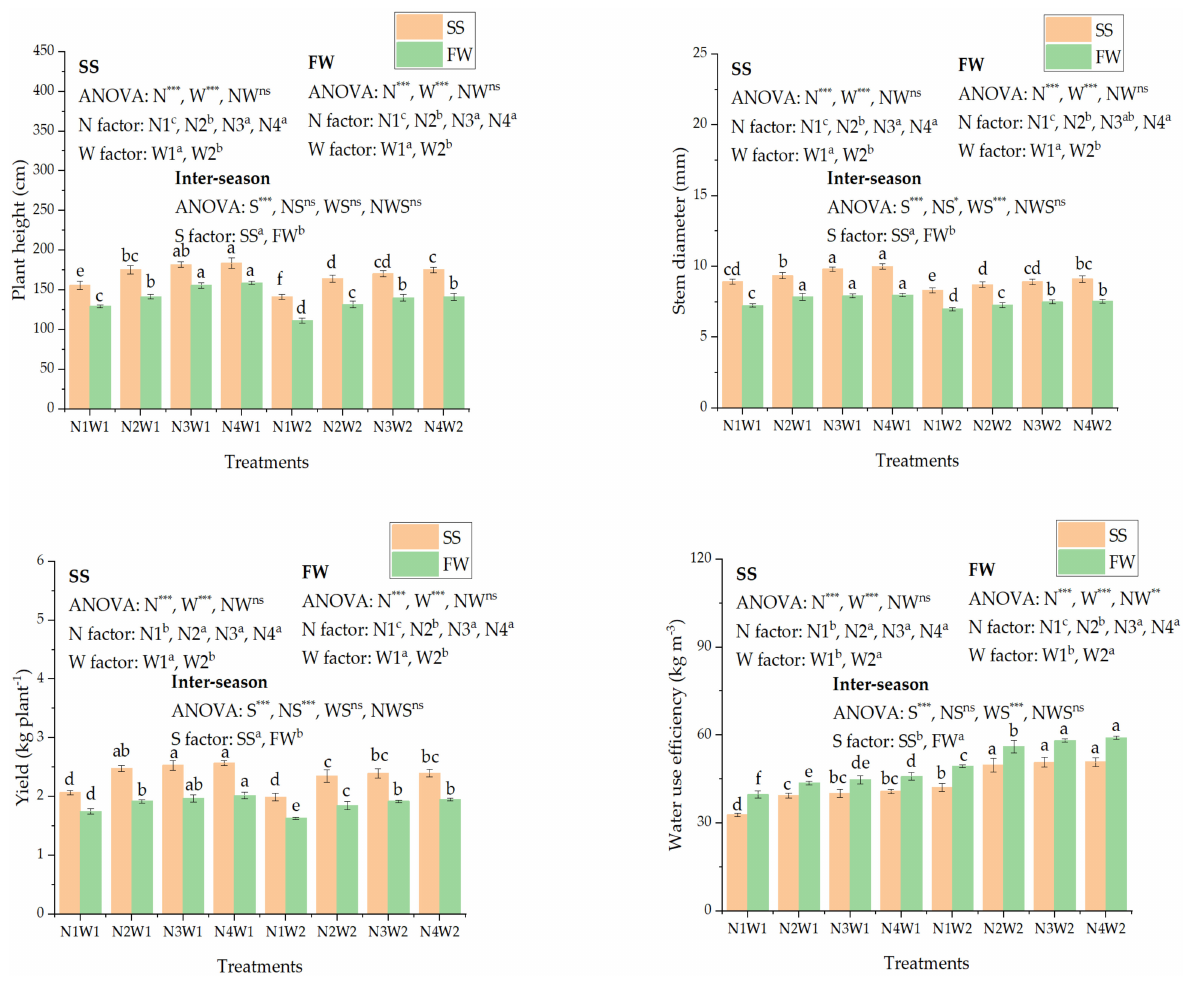
Figure 9. Effects of emitter density, irrigation level, and season on plant height, stem diameter, tomato yield, and water use efficiency for both SS and FW. N1, N2, N3, N4, W1, W2, SS, and FW: one emitter per plant, two emitters per plant, three emitters per plant, four emitters per plant, full irrigation, deficit irrigation, spring-summer cropping season, and fall-winter cropping season, respectively. *, **, ***, ns; significant at p < 0.05, significant at p < 0.01, significant at p < 0.001, and non-significant at p > 0.05. Values that are followed by different letters within the same columns differ significantly at p < 0.05. Data are given in means ± standard deviations ( n = 4) shown by vertical bars.